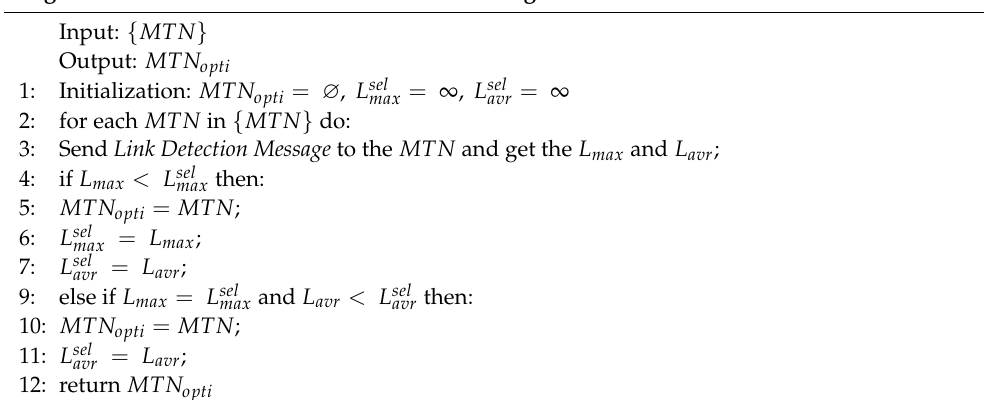
Algorithm 1. Path State-Aware MTN Selection